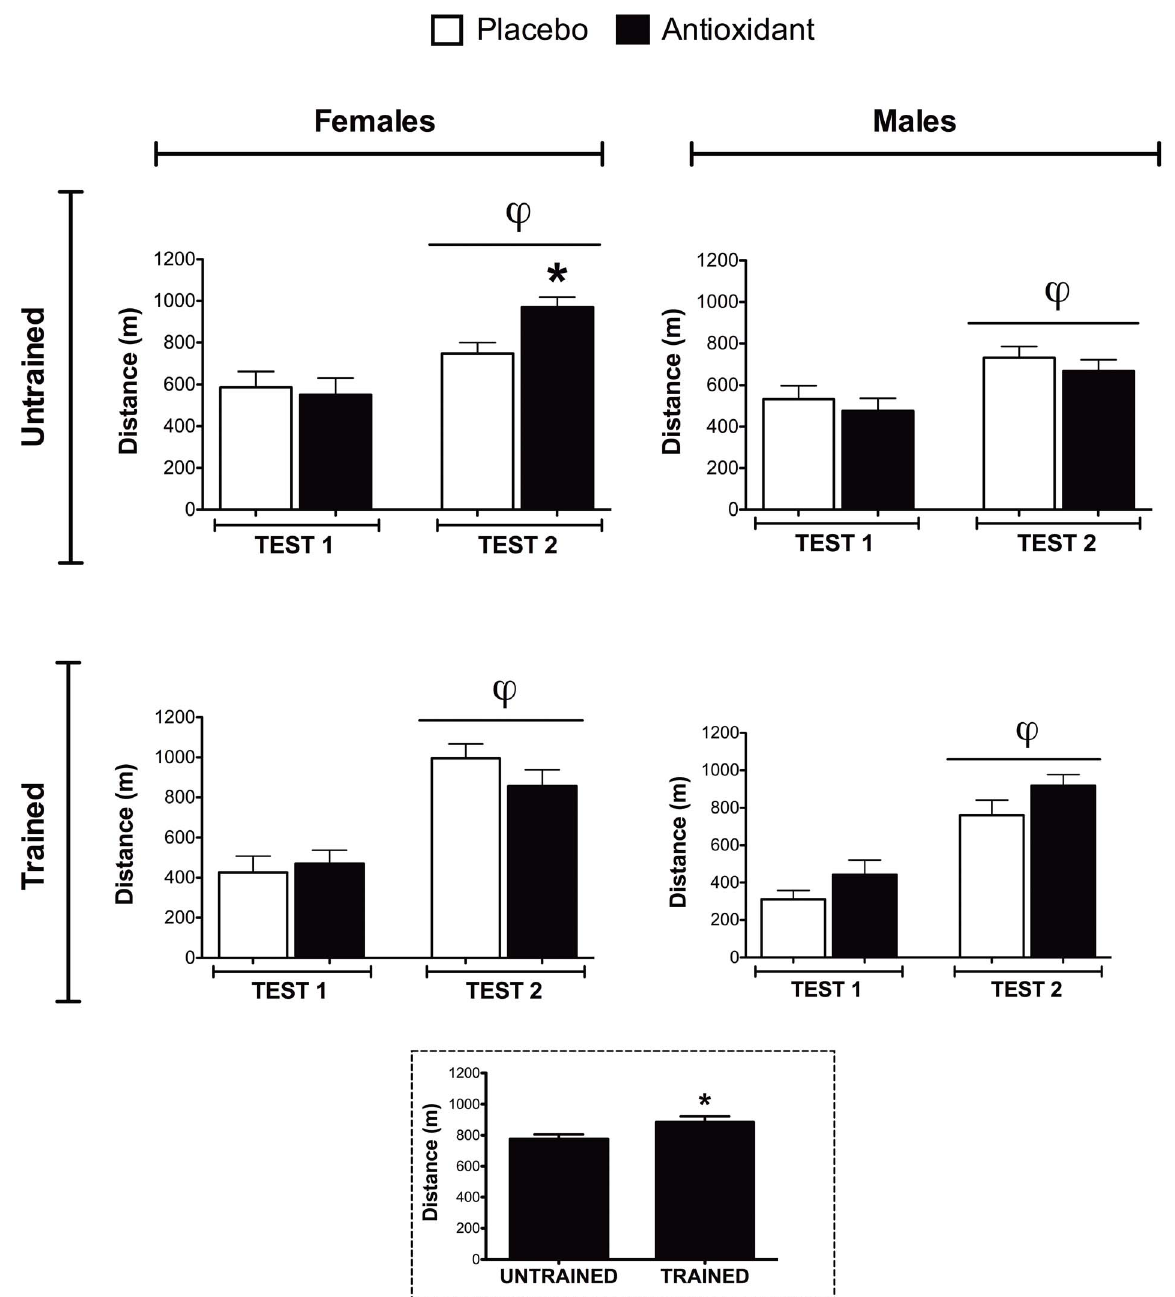
Figure 1. Exercise performance testing. Performance tests were conducted at the beginning (Test 1) and end of the study (Test 2). Running distance, calculated from both treadmill speed increments and time till exhaustion, was plotted. The performance of all the groups improved over the course of the study (Test 1 vs. Test 2, Q indicates main effect of testing, p # 0.05). Post-hoc testing was used to compare antioxidant- and placebo- supplemented groups, * indicates p # 0.05. Effect of training on performance is shown in the inset figure (dotted border) represented by the distance run during Test 2 for trained and untrained mice (unpaired T-Test, * indicates p # 0.05).